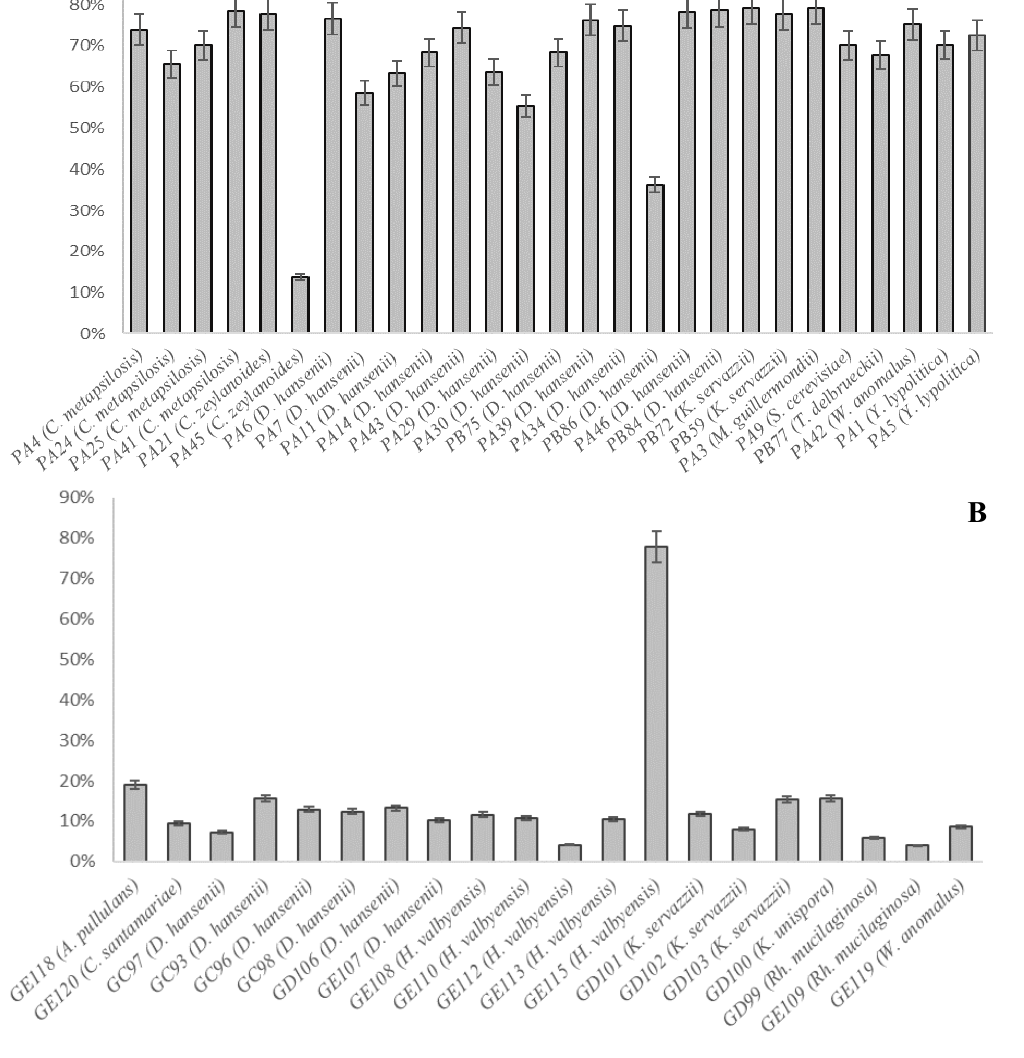
Figure 3. Antioxidant capability (%) of yeast strains isolated from pork meat ( A ) and game meat ( B ) products, according to the DPPH assay.